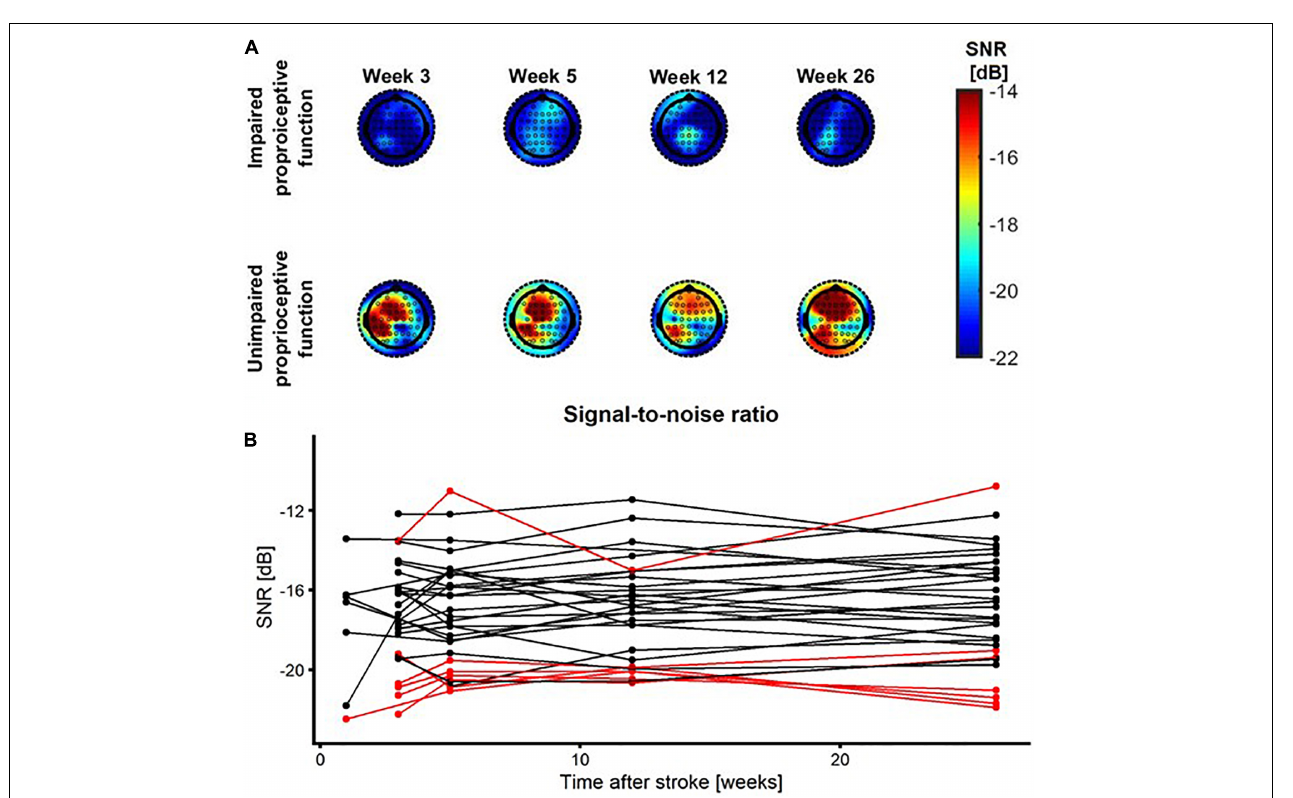
FIGURE 4 | SNR as a function of time after stroke. (A) SNR topoplots for one patient with impaired proprioception (top row) and for one patient with unimpaired proprioception (bottom row) at week 1, 3, 5, 12, and 26 after stroke. (B) SNR as a function of time after stroke. Red/black lines represent patients with impaired/unimpaired proprioception at baseline,